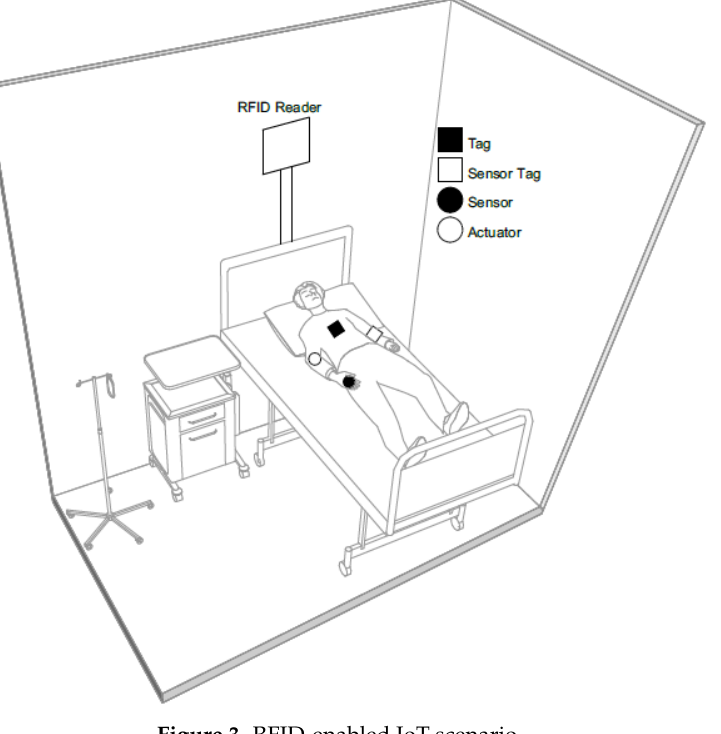
Figure 3. RFID-enabled IoT